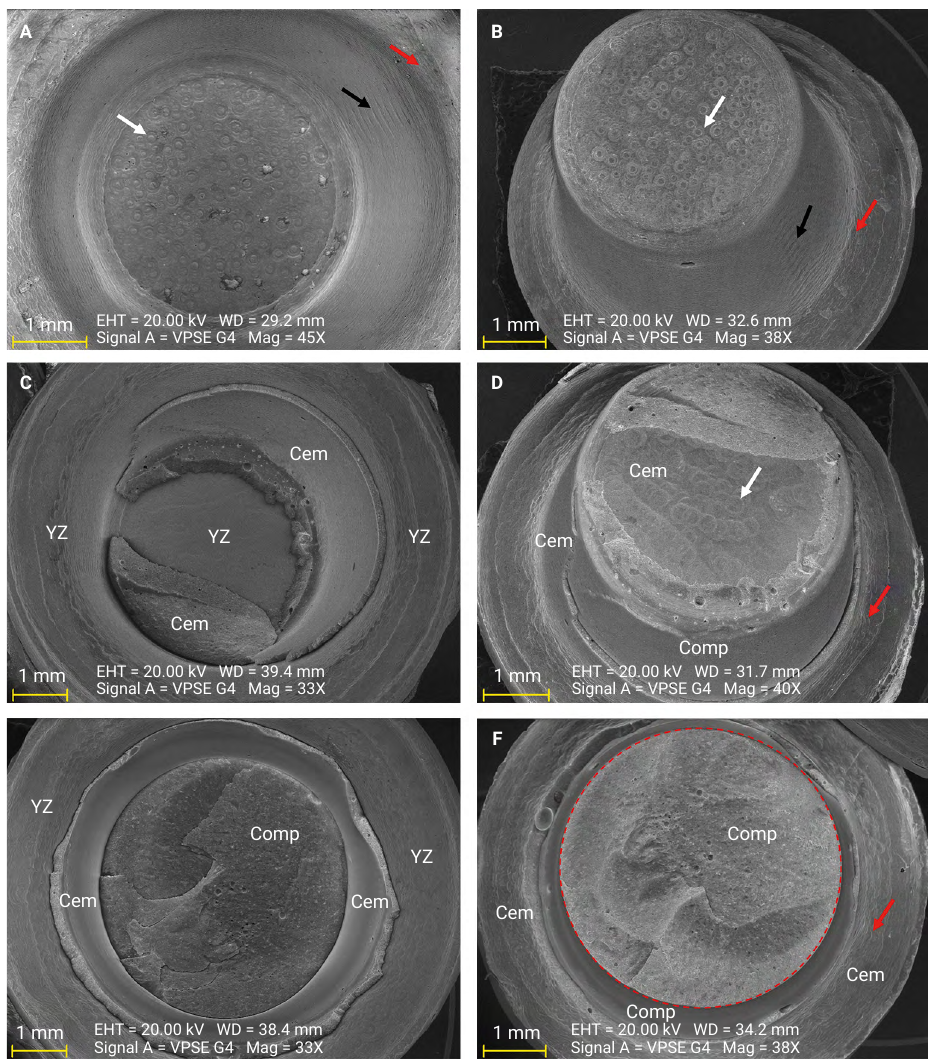
Figure 3. Representative scanning electric microscopies. A. Zirconia crown of the Coarse bur group (white arrow: circular machining marks on the internal occlusal surface; black arrow: axial machining marks on the axial internal surface; red arrow: semicircular machining marks on crown shoulder). B. Composite core of the Coarse bur group (it is possible to note that the resin cement layer is adhered totally on the core and the machining marks are reproduced on the cement layer) – 50S failure. C. Zirconia crown of the CTRL group (YZ: zirconia and Cem: cement) – cement partially adhered on crown. D. Composite core of the CTRL group (major part of cement adhered on composite surface) and machining marks on the layer cement – 50S failure. E. Zirconia crown of the Extra fine bur group – Cohesive failure (part of the core fracture into crown. F. Composite core of the Extra fine group (red circle: fractured occlusal third; cement adhered on the composite shoulder with semicircular machining